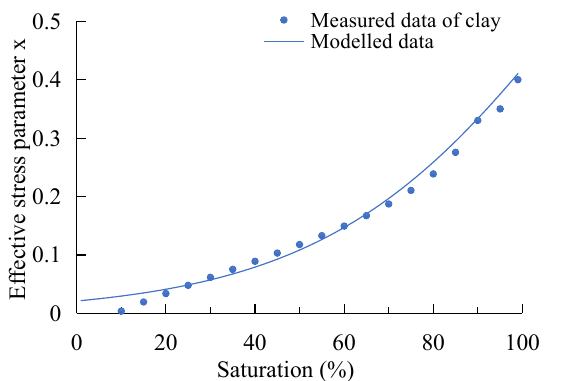
Figure 23. Effective stress parameter χ based on the calculated data [27] and the fitted